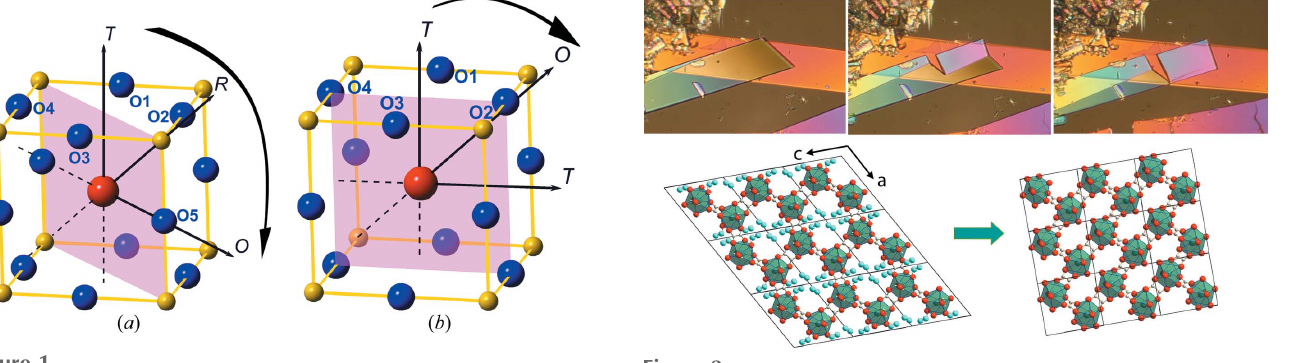
Figure 2 (Top) Optical micrographs of Sm 2 (C 2 O 4 ) 3 (cid:3) 10H 2 O during dehydration to Sm 2 (C 2 O 4 ) 3 (cid:3) 6H 2 O on heating. (Bottom) The orientation of the fragments of the crystal structures corresponds to the crystal shape. The hexahydrate crystal remains in the same plane. Figure taken from Matvienko et al. (2017).